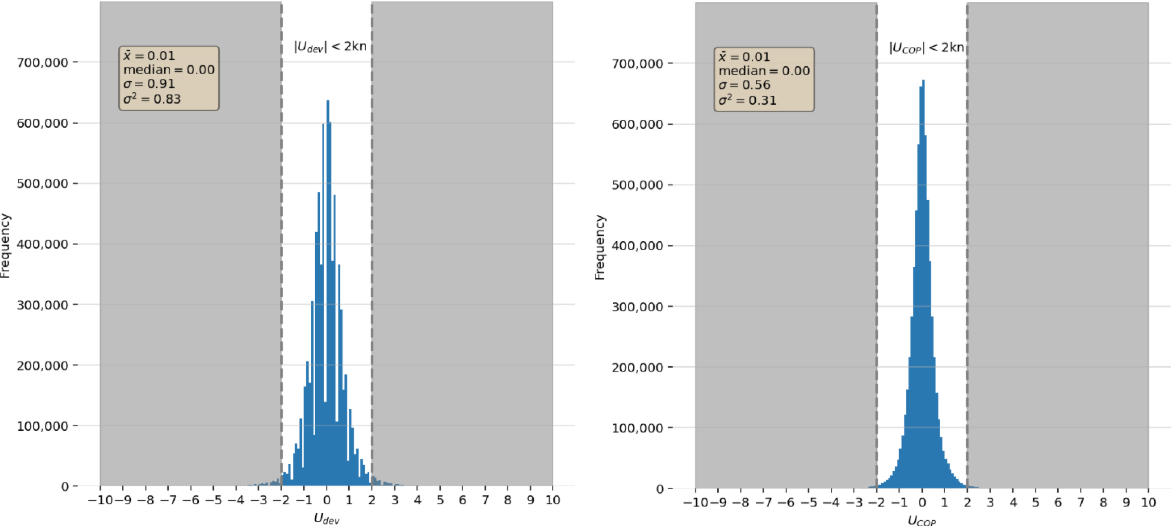
Figure 12. Distribution histograms of U dev and U COP for 190 container